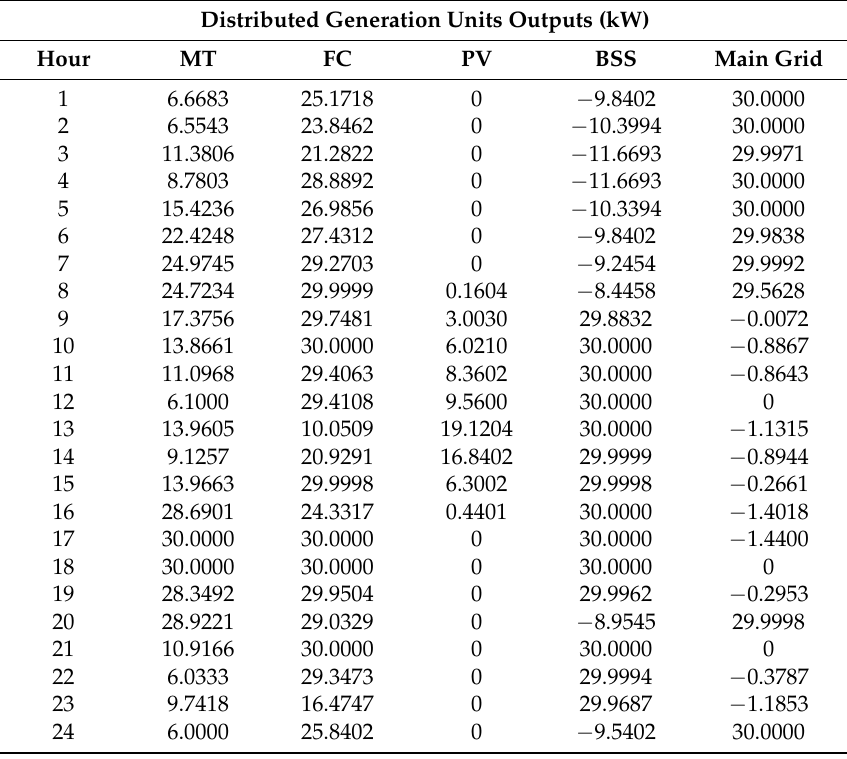
Table 7. Day-ahead energy scheduling of MG components.